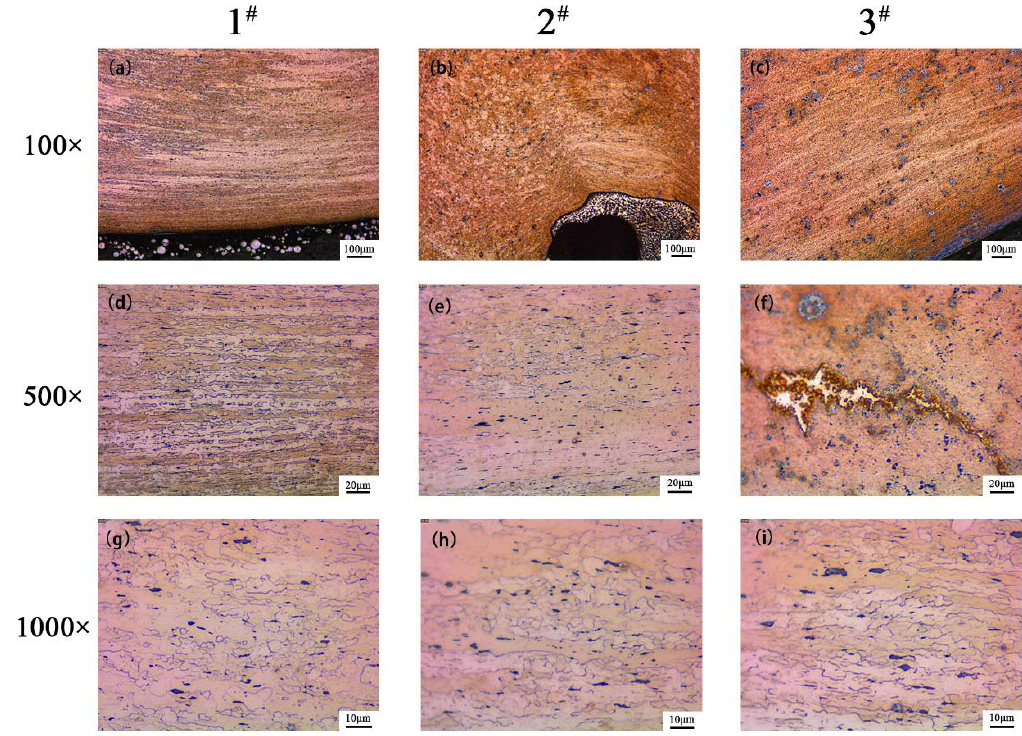
Figure 19. The metallographic picture of Mo-10Ta alloy slug, ( a , d , g ) are the grain morphology at position 1 # of the slug; ( b , e ) and ( h ) are the grain morphology at position 2 # of the slug; ( c , f , i ) are the grain morphology at position 3 # of the